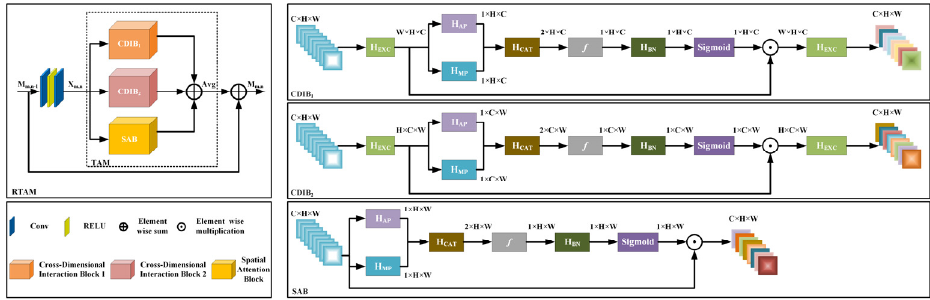
Figure 3. The framework of the proposed residual triplet attention module (RTAM).